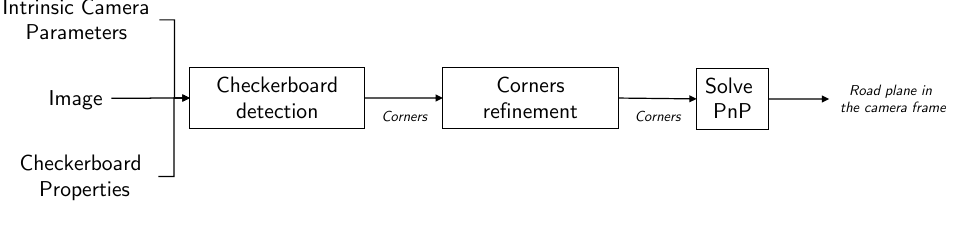
Figure 3. Road plane estimation